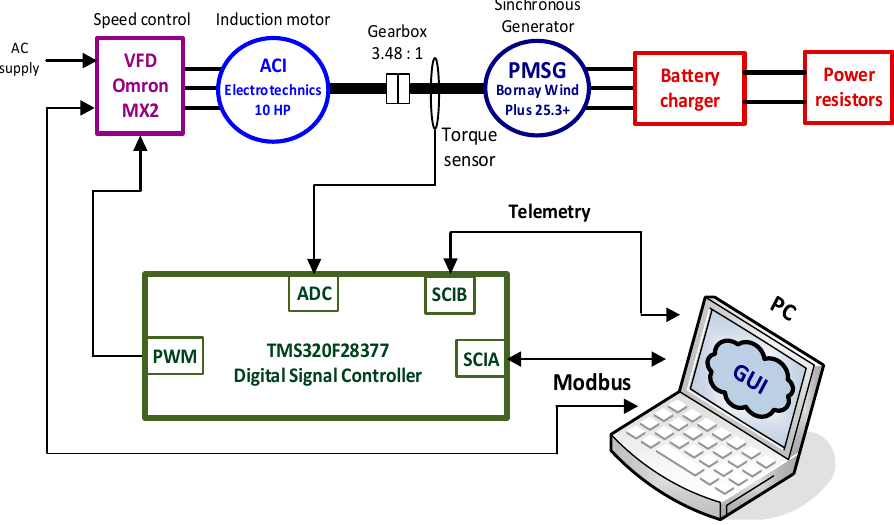
Figure 12. Block diagram of the proposed wind turbine emulator.